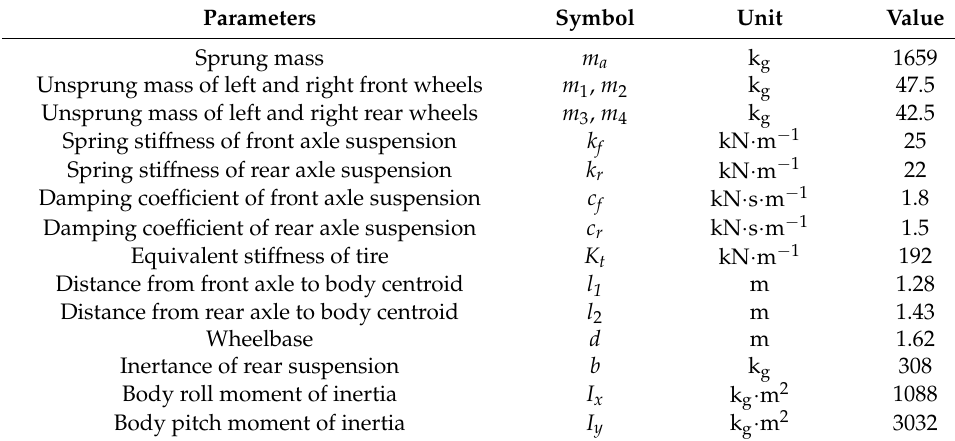
Table 1. Main parameters of the vehicle